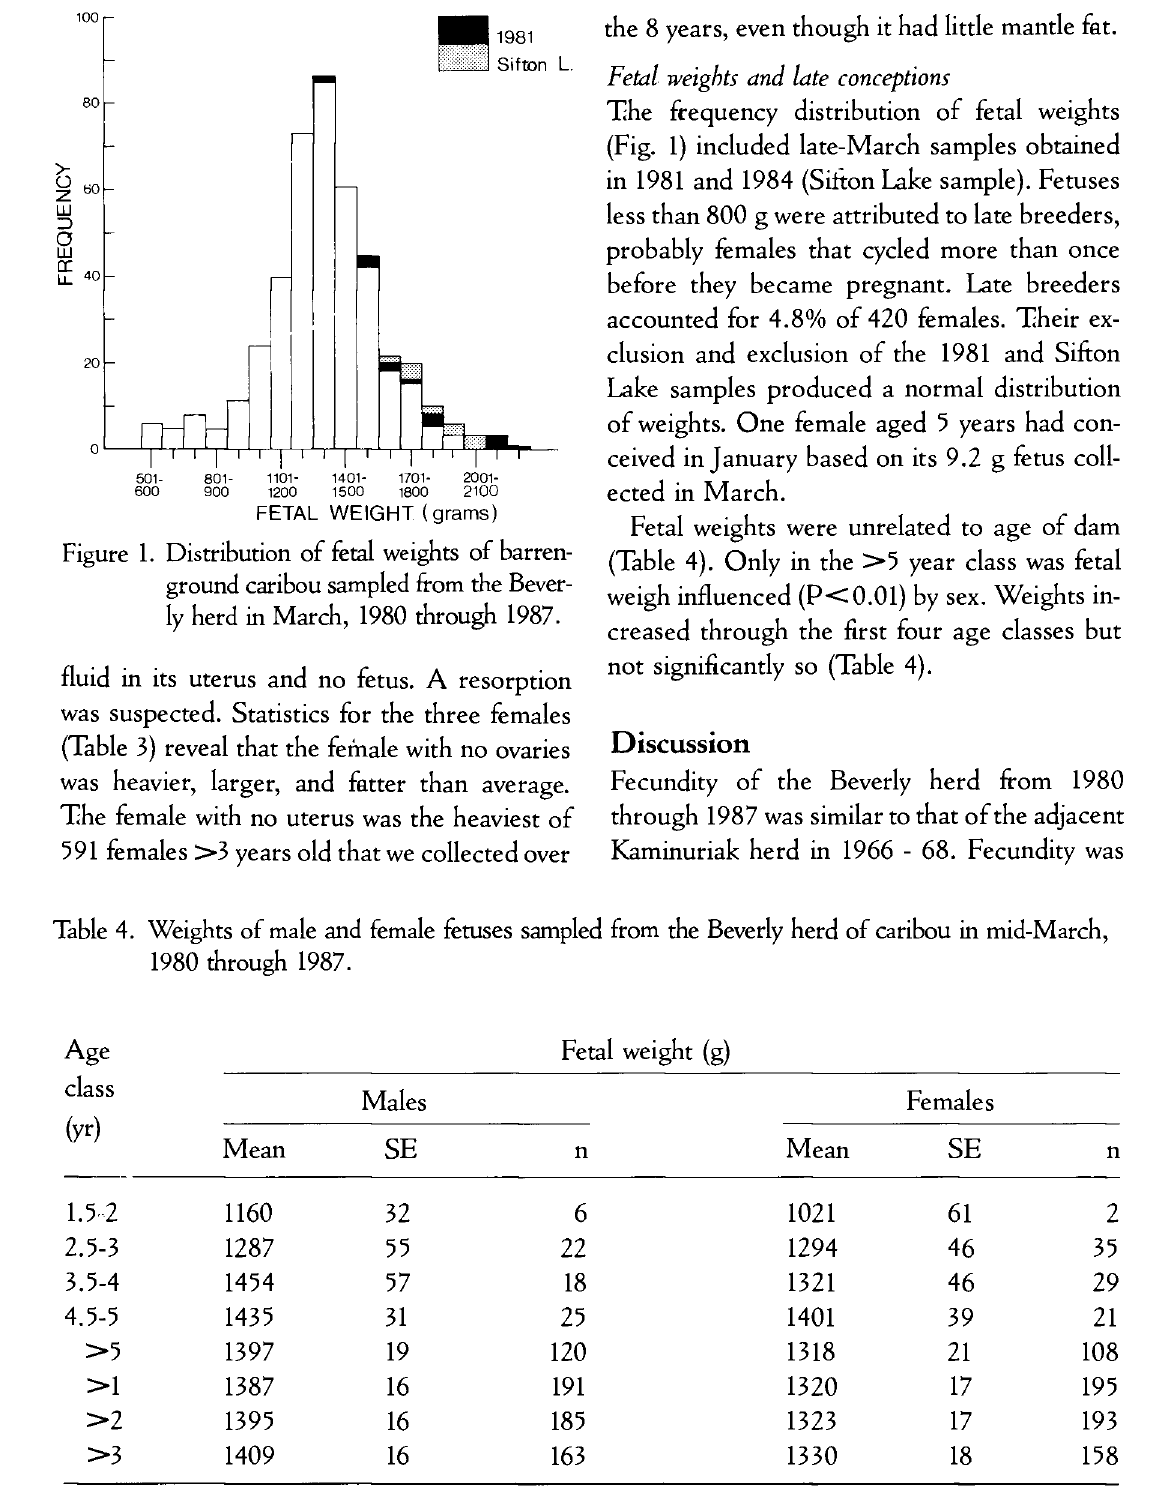
Figure 1. Distribution of fetal weights of barren- ground caribou sampled from the Bever ly herd in March, 1980 through